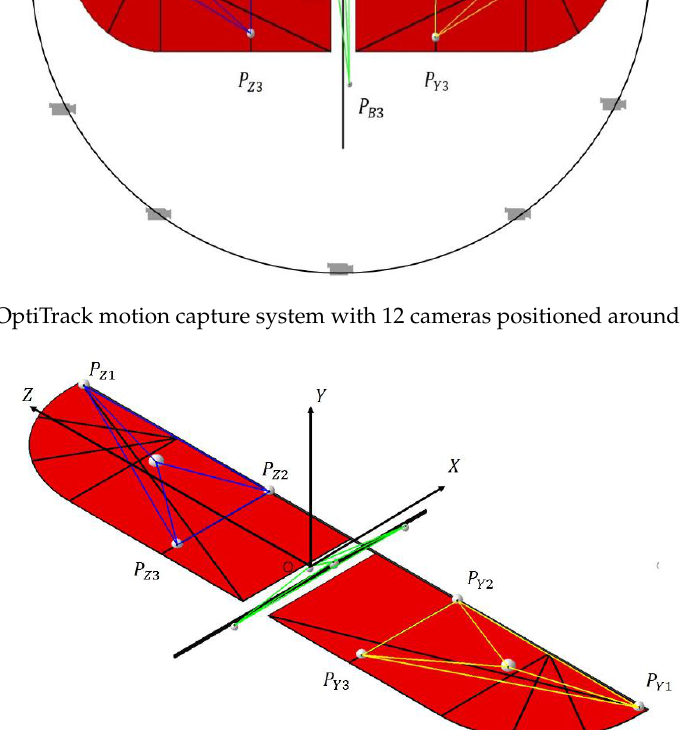
Figure 8. The wing and reflective balls in the body coordinate system. The flapping angle of the wing is measured as the angle between the leading edge 𝑃 𝑦1 − 𝑃 𝑦2 and its projecting line on the XoZ plane as shown in Figure 9. Therefore, the flapping angle θ is positive when the wing is above the XoZ plane and can be expressed as: